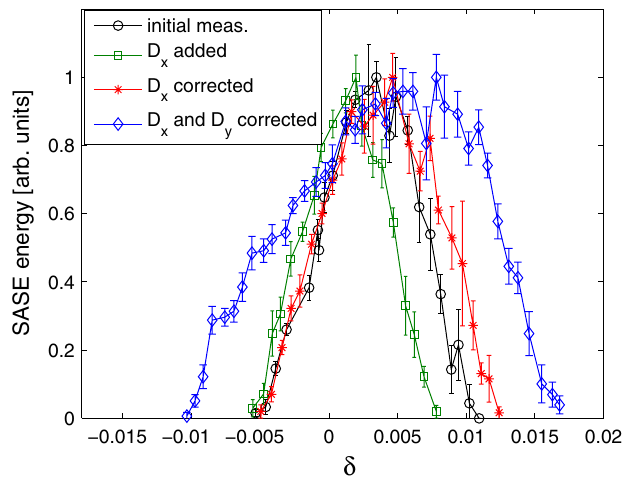
FIG. 8. (Color) Measurements and simulations of SASE FIG. 7. (Color) Measured SASE energy as a function of ) for the different dispersion energy as a function of electron energy offset before and after electron energy offset ( (cid:1) ¼ (cid:1) p=p 0 scenarios. correction.